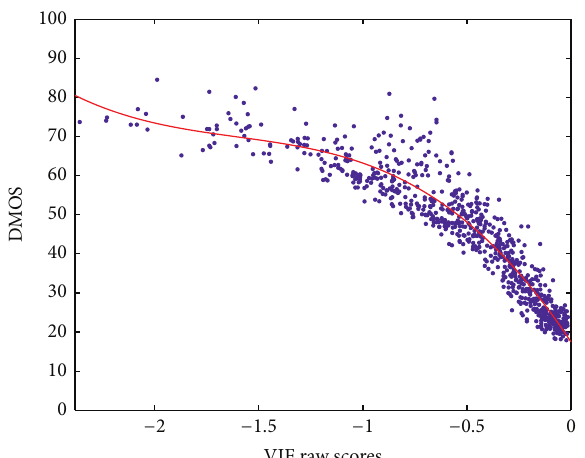
Figure 4: Dispersion plot used for the VIF metric including the curve fit for (1).